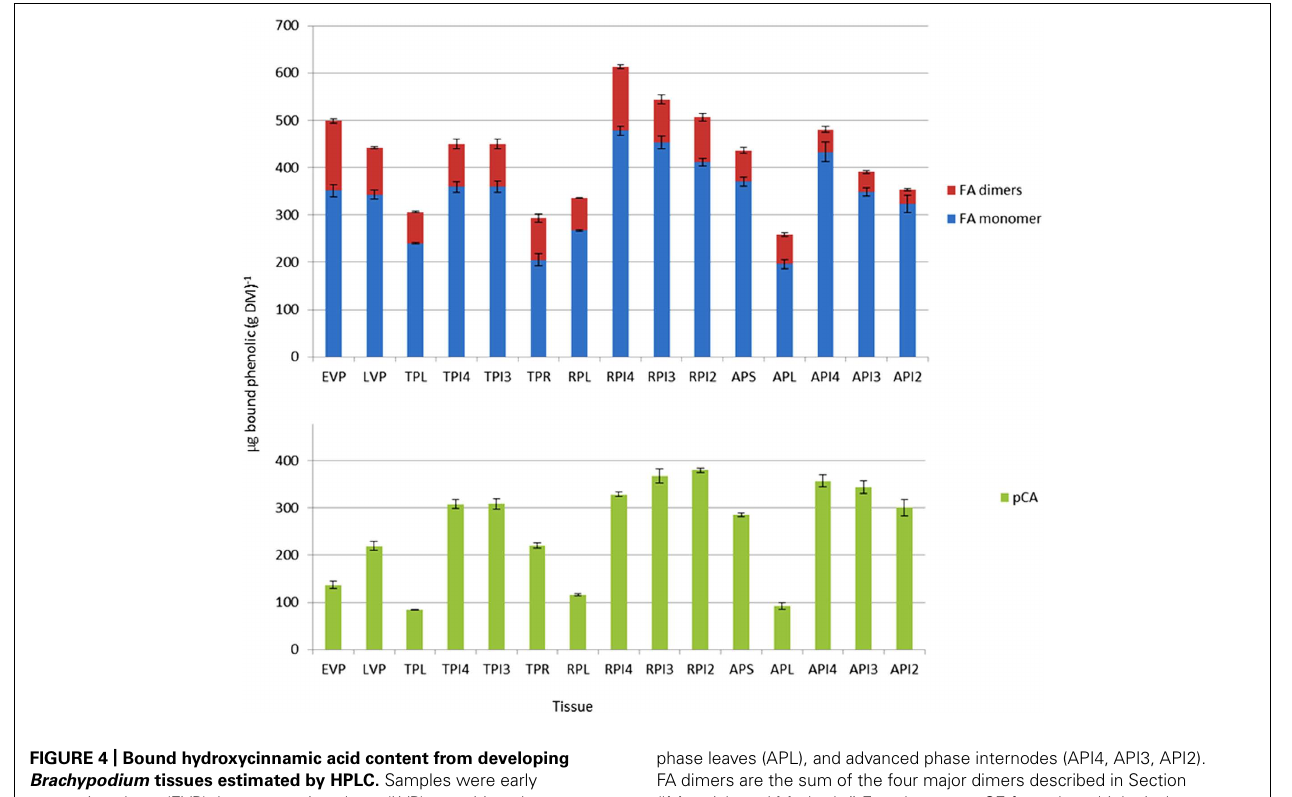
phase leaves (APL), and advanced phase internodes (API4, API3, API2). FA dimers are the sum of the four major dimers described in Section “Materials and Methods.” Error bars are ± SE from three biological replicates. One-way analysis of variance showed that the effect of tissue/stage on both total FA and pCA content was significant at F probability < 0.001.